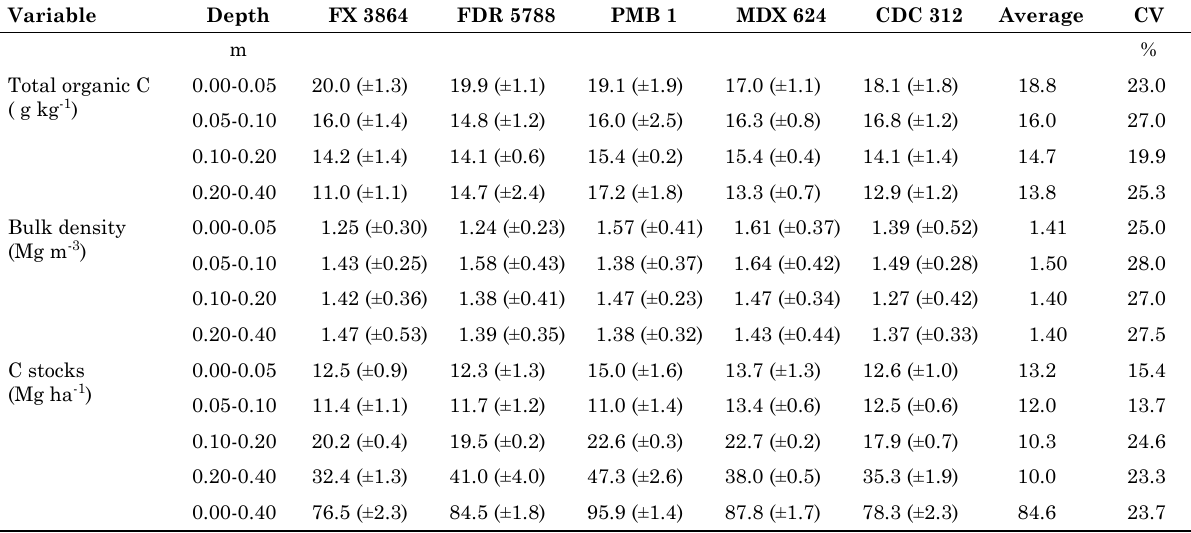
Table 3. Carbon content, bulk density, and carbon stocks in the soil planted to rubber tree clones Variable Total organic C ( g kg -1 )